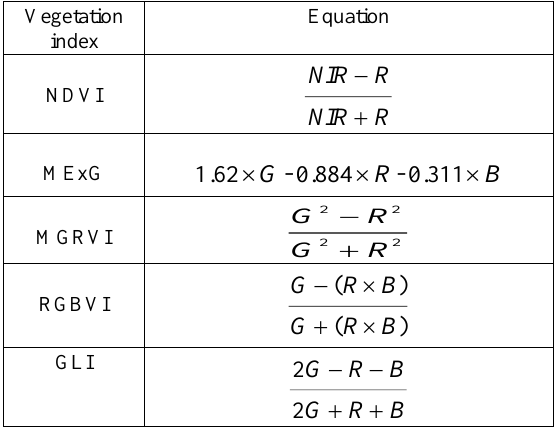
Table 2. Vegetation indices used in the study (R: Red, G: Green and B: Blue